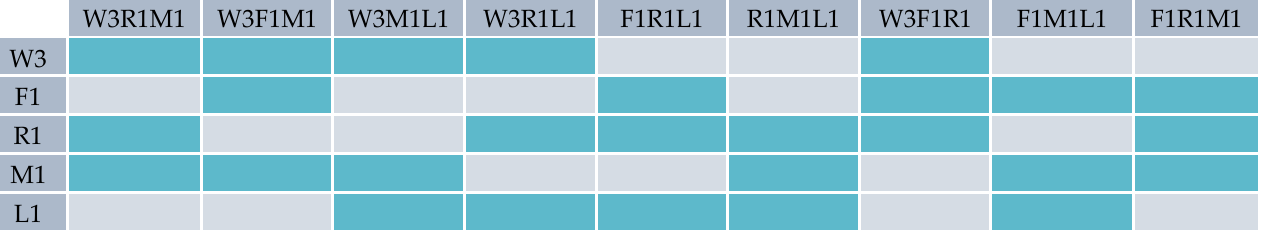
Figure 16. The formulated combinations of the selected best strategies.